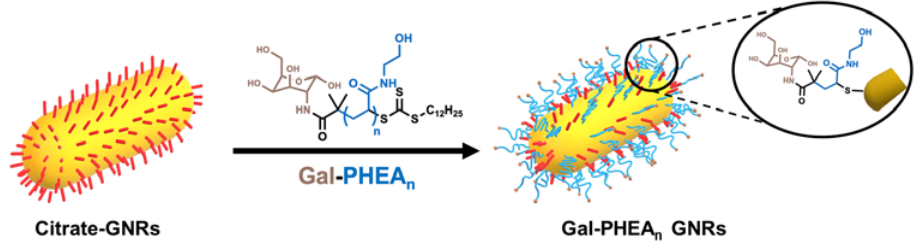
Figure 2. Functionalization of citrate-stabilized gold nanorods using Gal-PHEA telechelic homopoly- mers of different chain lengths (n). Note, RAFT agent cleavage can occur during functionalization depending on the excess used, but does not affect GNR immobilization.